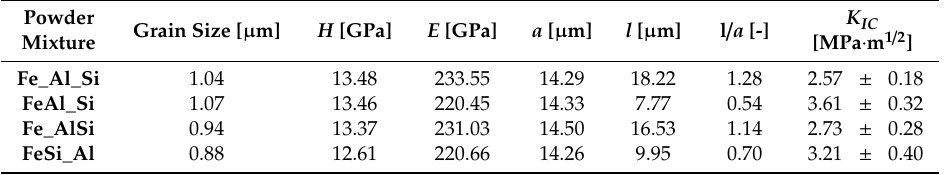
Figure 9. Microstructure of the compacted powder Fe_AlSi. Table 1. Average grain size and fracture toughness of the samples prepared by SPS (measured at the maximum load of 5 N).